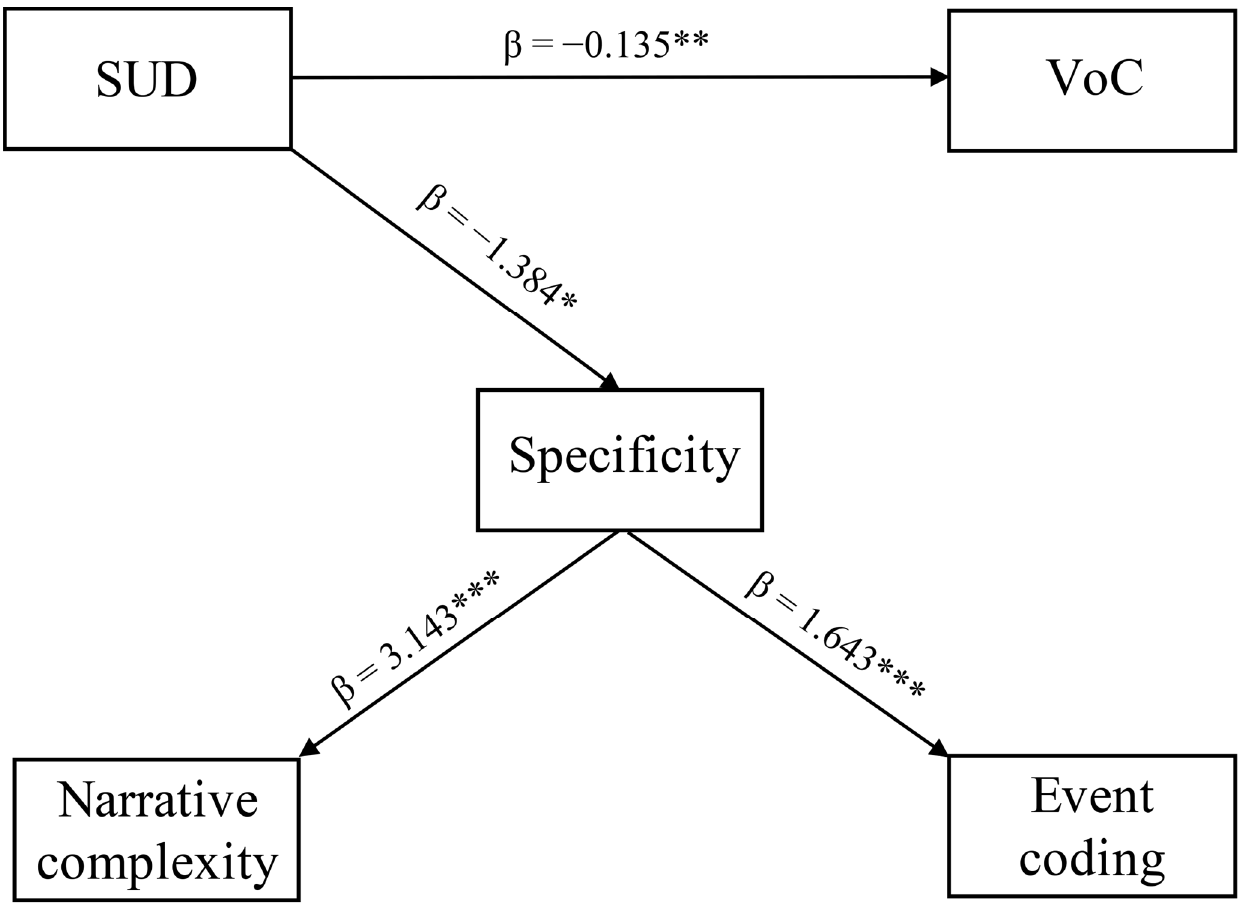
Figure 2. Path analytic model showing SUD scale as a predictor of both VoC scale and specificity level, and the latter, in turn, acting as a predictor of both narrative complexity levels and “relationship” event coding. * p < 0.05, ** p < 0.01, *** p < 0.001